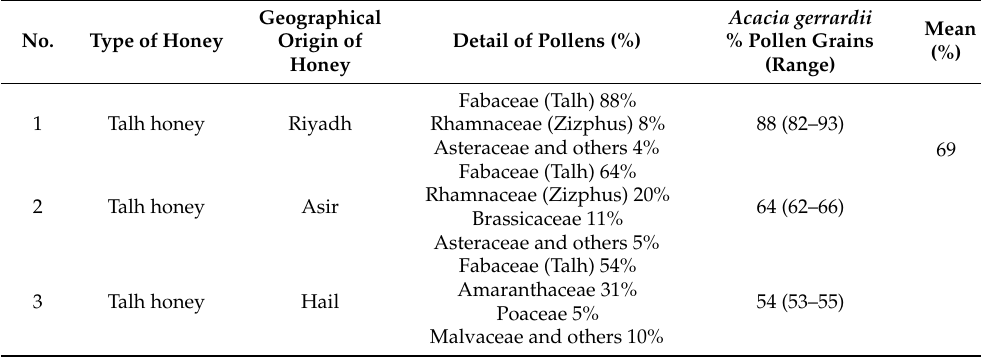
Table 1. Acacia gerrardii pollen grains in Talh honey dependent on the analysis of the honey pollen grains. Geographical No. Type of Honey Origin of Detail of Pollens Honey